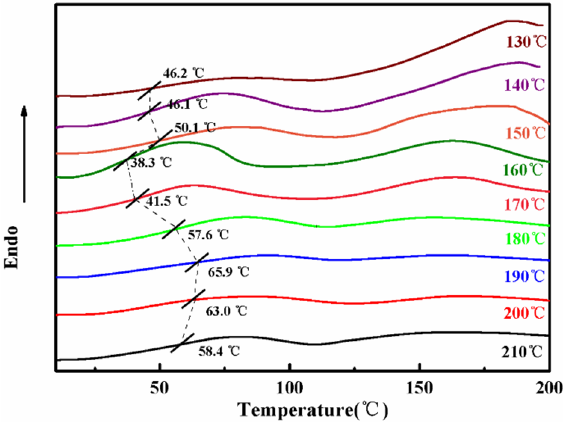
Figure 6. DSC spectra of coatings cured at different temperatures.